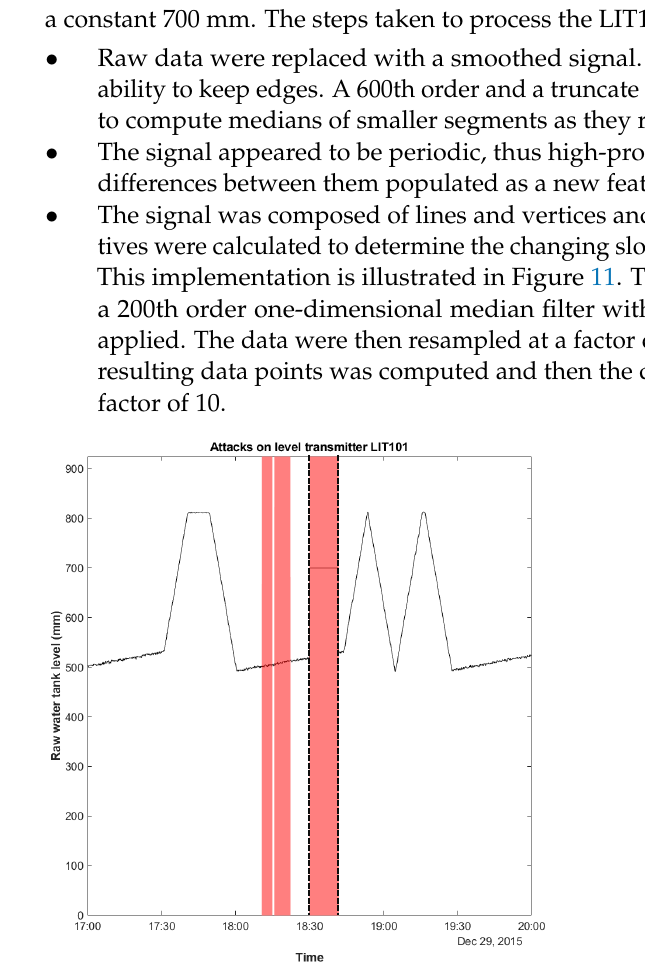
Figure 10. Attacks on level transmitter LIT101. Figure 10. A tt acks on level transmi tt er LIT101. Figure 10. A tt acks on level transmi tt er LIT101.